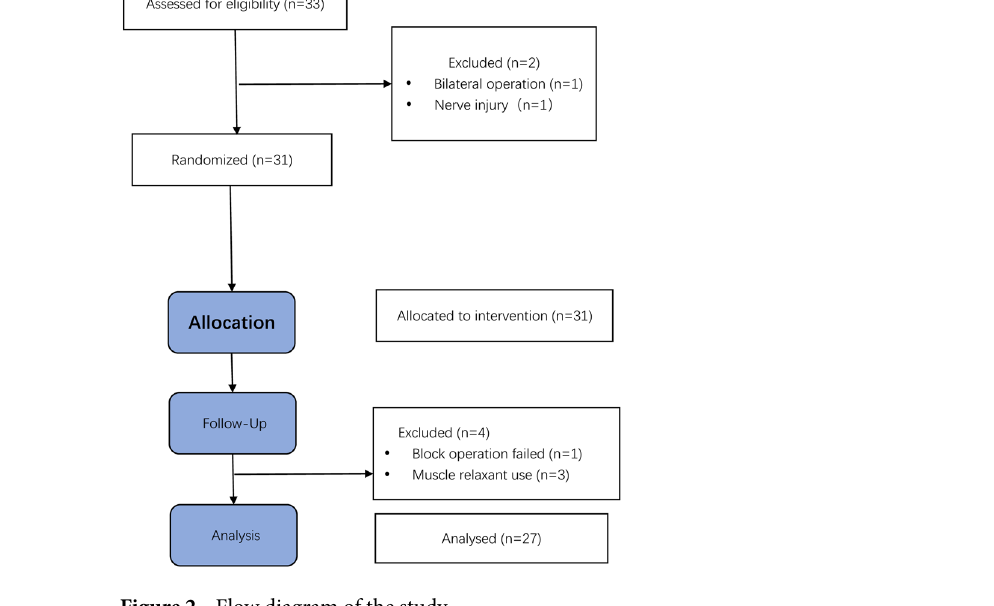
Figure 2. Flow diagram of the study.